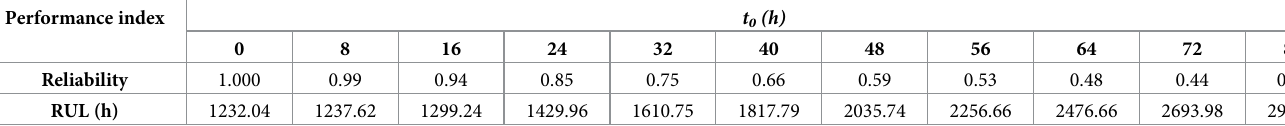
Table 7. RUL values during 80 operational hours of the excavator in the Weibull-frailty model. Performance